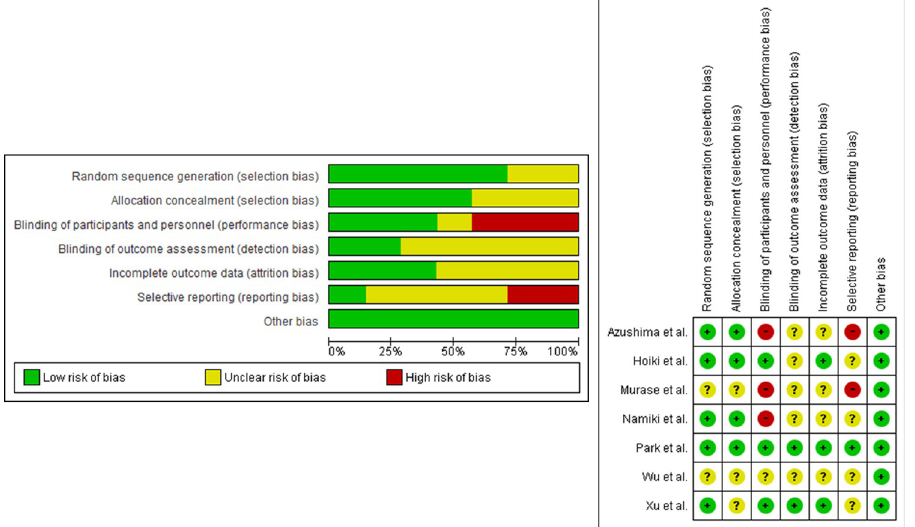
Fig 2. Risk of bias assessment for included